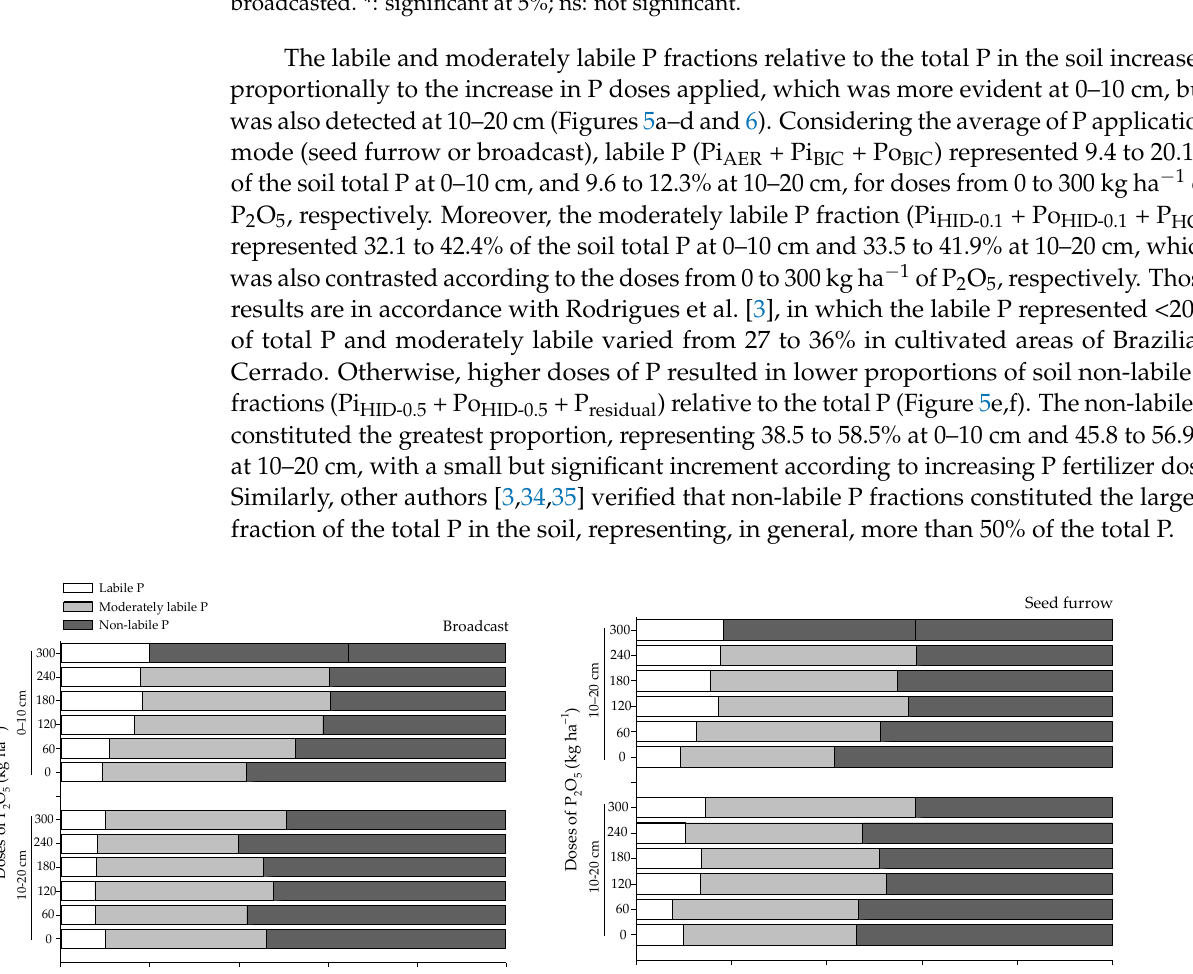
Relative contribution (%)